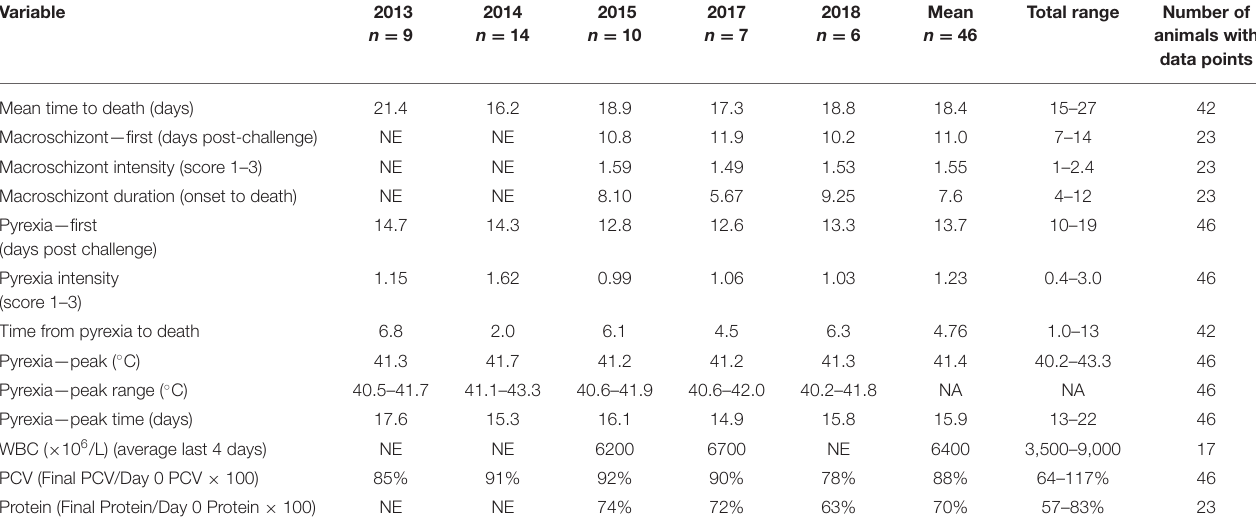
TABLE 2 | Mean values for clinical variables measured during five trials N = 9 (2013), 14 (2014), 10 (2015), 7 (2017), and 6 (2018).